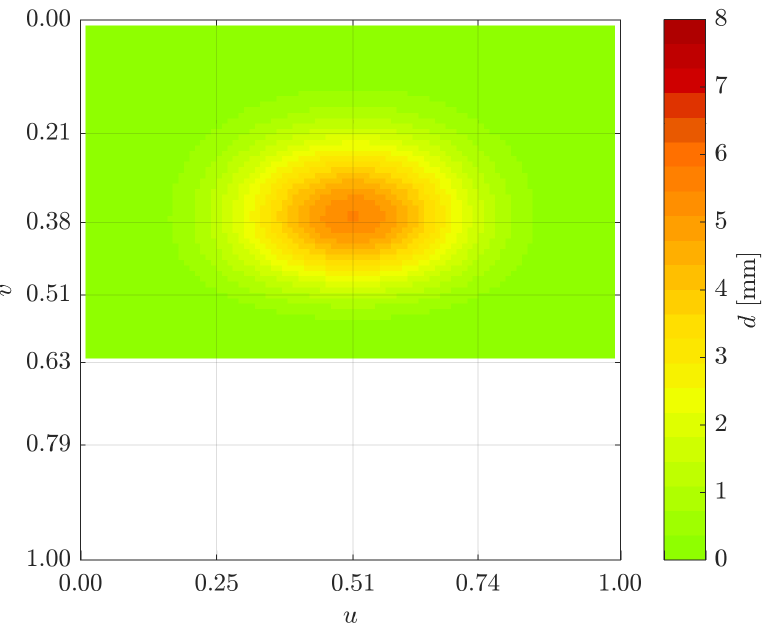
Figure 8. Distances d between corresponding surface points after having shifted control point P 3,3 by 1.2 cm in x -direction. Presentation of the influenced area in the parameter space